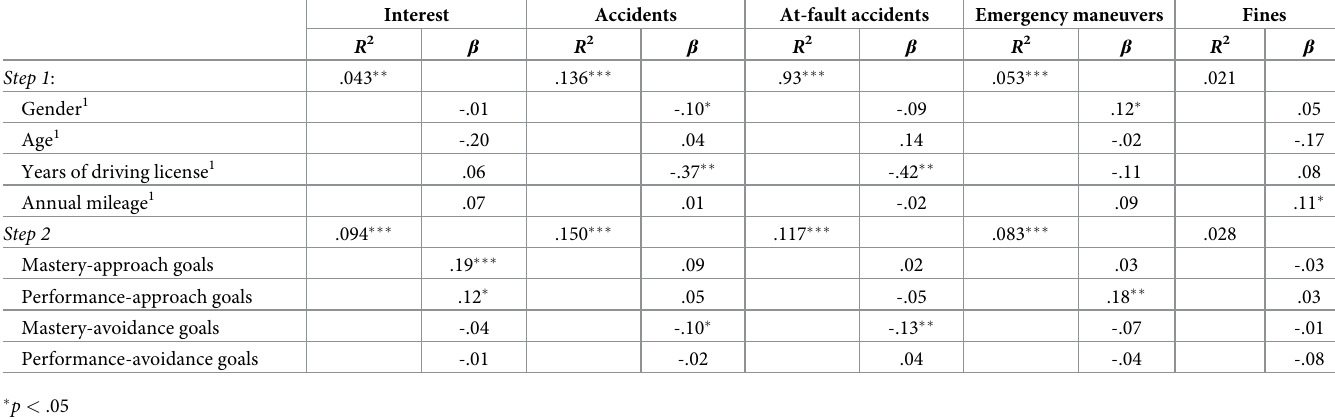
Table 5. Summary of hierarchical regression analyses predicting interest, accidents, at-fault accidents, emergency maneuvers, and fines. Interest